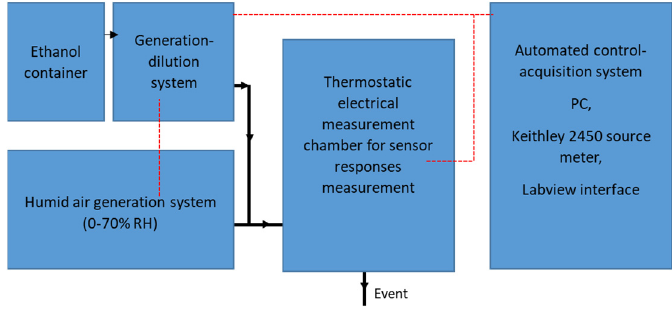
Figure 2 . Schematic diagram of the test bench set up. Figure 2. Schematic diagram of the test bench set